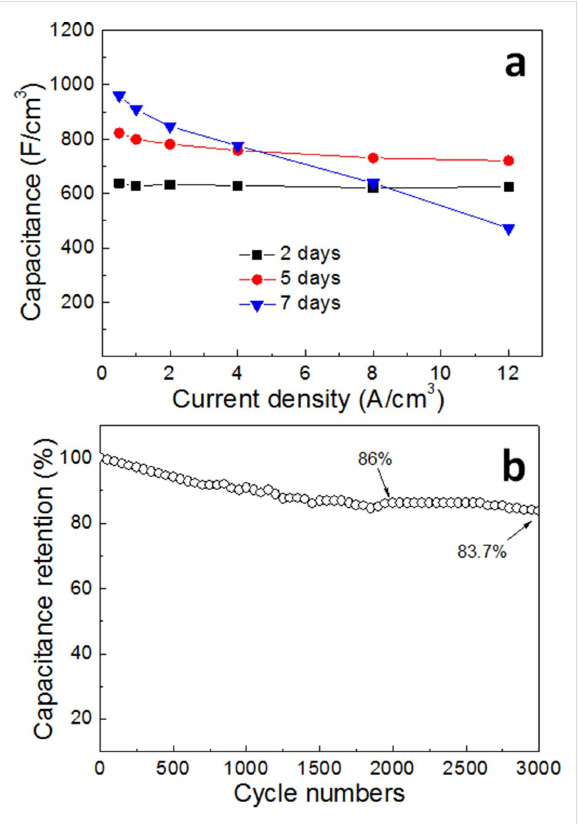
Figure 6: (a) Volumetric capacitance of the Ni(OH) 2 /Ni-NF/MG-2, Ni(OH) 2 /Ni-NF/MG-5, Ni(OH) 2 /Ni-NF/MG-7 electrodes at different dis- charge current densities; (b) volumetric capacitance versus cycle num- ber of Ni(OH) 2 /Ni-NF/MG-5 at a galvanostatic charge and discharge current density of 1 A/cm 3